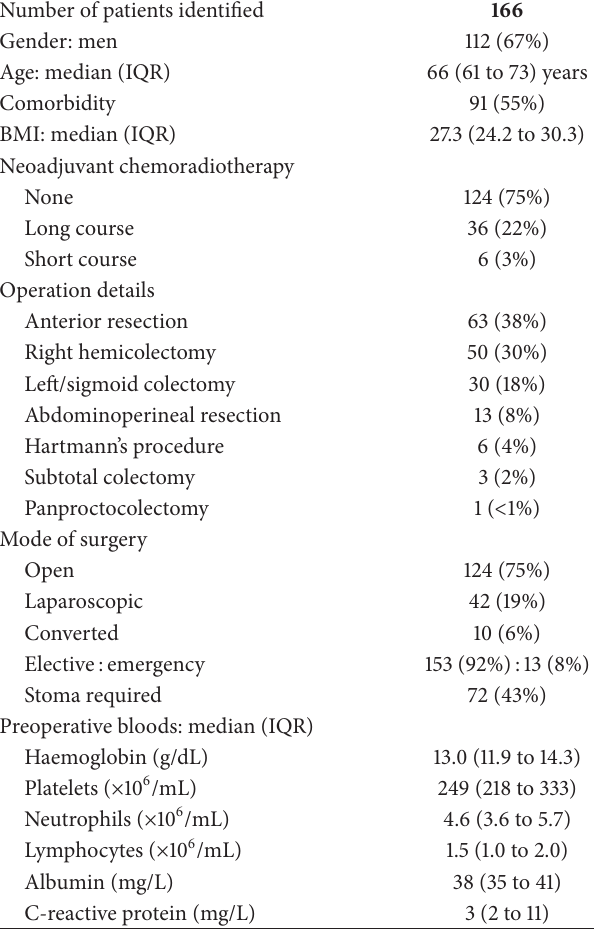
Table 1: Patient demographics and operative details. Number of patients identified